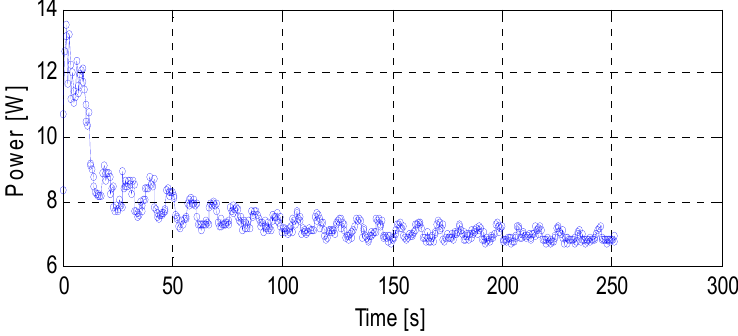
Figure 9. Power consumption during Bosch coring bit test performed on Szydłowiec sandstone A—soft sample with motor’s power supply voltage 24 V and weight on bit (WOB) 105.75 N.